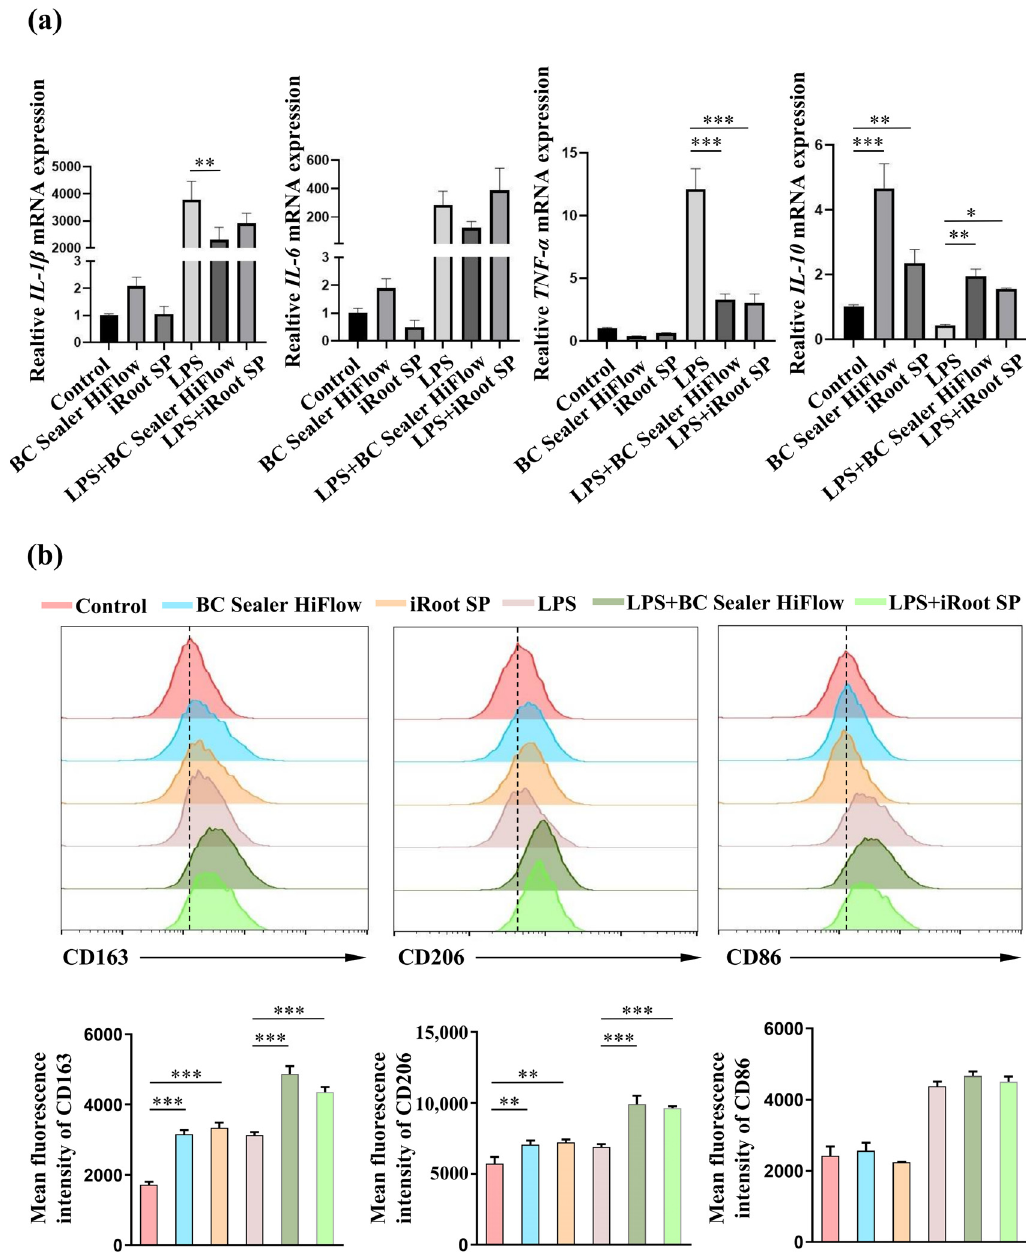
Figure 5. In vitro macrophage polarization in response to BC Sealer HiFlow and iRoot SP. The BMDMs were stimulated with BC Sealer HiFlow or Root SP in the presence or absence of LPS for 12 h. ( a ) The mRNA levels of IL-1 β , IL-6 , TNF- α , and IL-10 in BMDMs were analyzed by qPCR. ( b ) The fluorescence intensity of CD163, CD206 and CD86 on the surface of BMDMs was assessed by flow cytometry. * p < 0.05, ** p < 0.01, *** p <